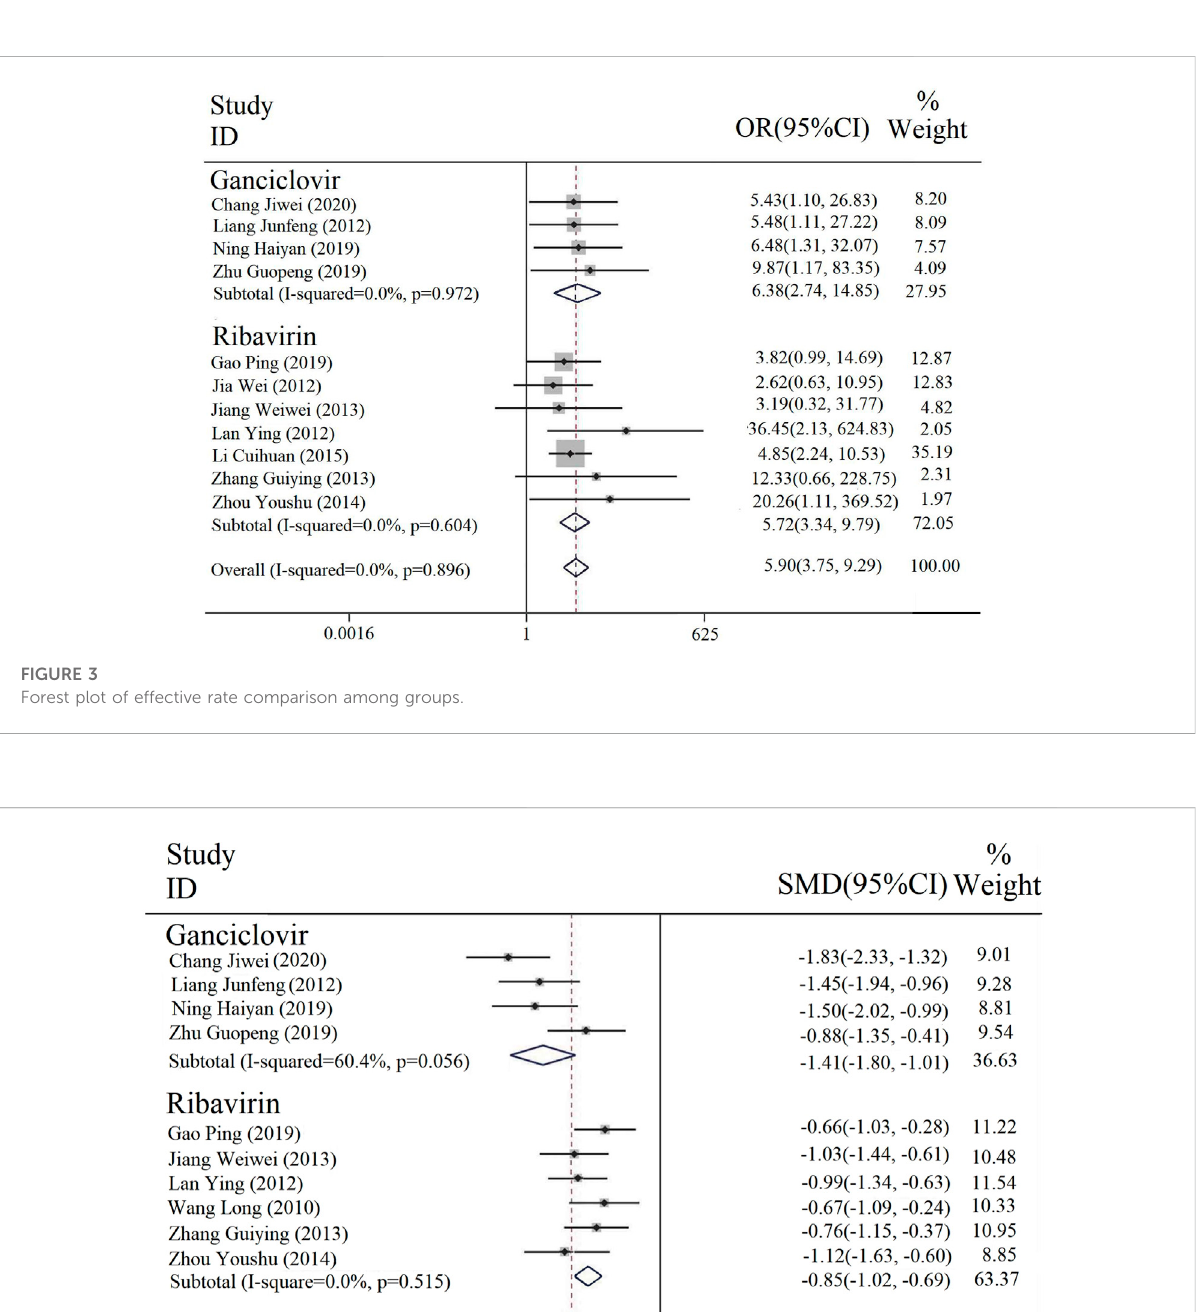
or without conventional therapy). The subgroup analysis was conducted on different interventions, and the heterogeneity results among the subgroups were [ p = 0.004, I 2 = 77.4%; p = 0.023, I 2 = 61.7%]. A random effect model was selected for